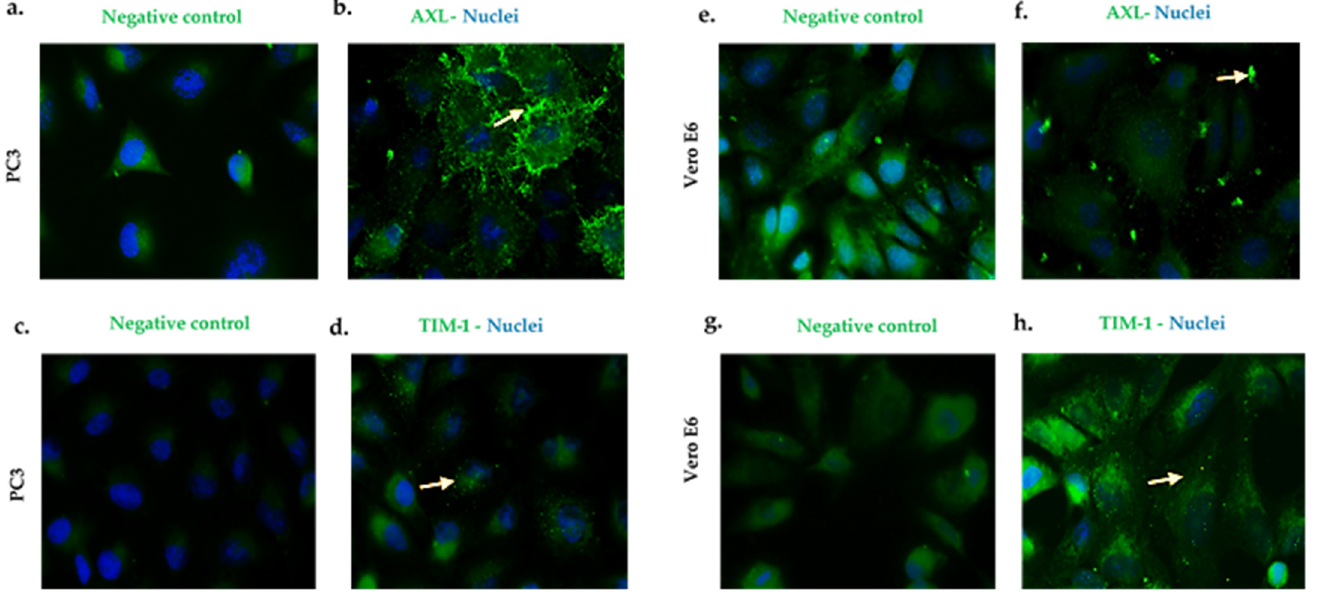
Figure 2 . PC3 and Vero E6 cells express AXL and TIM-1 cell receptors. Pictures were captured at a 60× magnification. The photographs represent the subcellular location of AXL ( b , f ) and TIM-1 ( d , h ), and they correspond to three independent triplicate experiments. AXL and TIM-1 (green), and nuclei (blue). ( a , c , e , g ) are cells antibody secondary labeled and correspond to the negative controls. After the examination of the subcellular distribution of the receptors for ZIK, with the intention of determining the impact of the viral infection on the expression of the re- ceptors, the cells were inoculated at a MOI = 1 with ZIKV during 24 h.p.i., but the receptors expressions were not altered (Figure 3). However, when the PC3 cell line was infected at a MOI = 3, the AXL receptor expression increased (Figure S3). PC3 ( b ) Figure 3 . Expression of AXL and TIM-1 receptors in PC3 ( a ) and Vero E6. ( b ) The infected and un- infected cells after 24 h were detected by flow cytometry. Analysis shows mean and SEM (Standard Error Medium) from independent experiments. 3.3. The Colombian ZIKV Isolate Replicates in PC3 Cells Once the altered expression of the cellular receptors for ZIKV were seen, the role of the viral growth dynamics was evaluated. To determine the percentage of the infection of the ZIKV, the PC3 and Vero E6 cells were inoculated at several MOIs (0.1, 1, and 3) (Figure S4). Considering the results, MOI = 1 was chosen for infecting the cells and to evaluate the virus replication cycle. Viral kinetics using the plaque-forming units in the PC3 (Figure